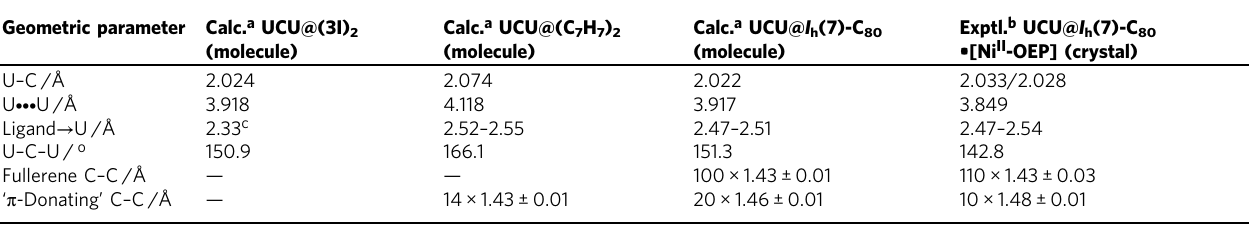
Table 1 Calculated and experimentally derived geometric parameters of UCU groups Geometric parameter Calc. a UCU@(3I) 2